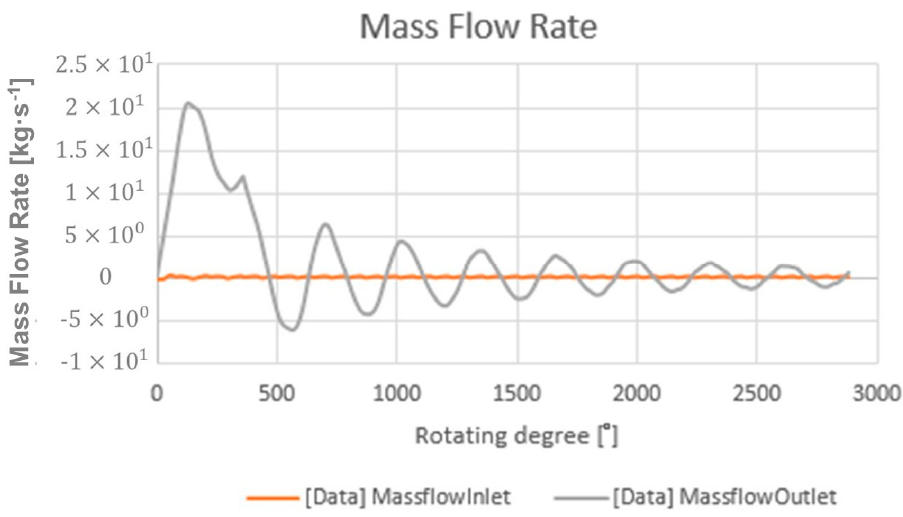
Figure 12. The mass flow rate at inlet and outlet.